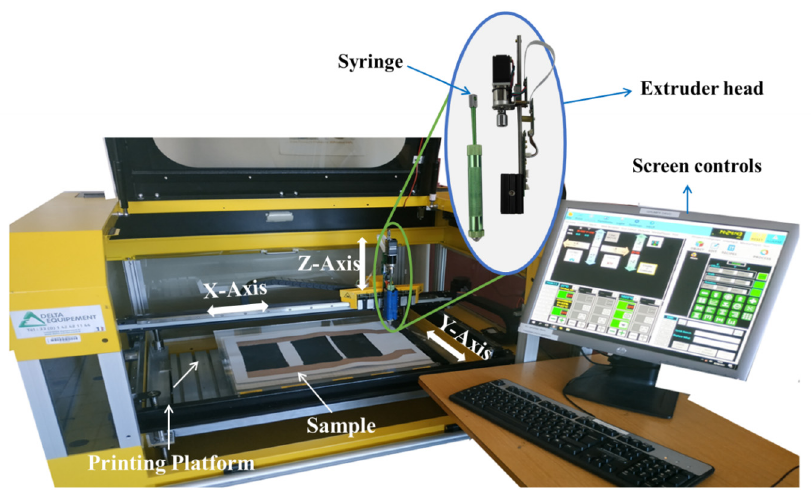
Figure 2. Cross-sectional illustration of the 3D printing process.